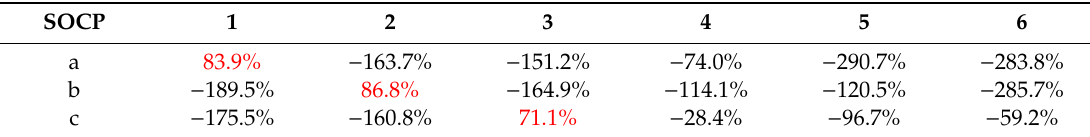
Table 3. The similarity of the contours parameters in Figure